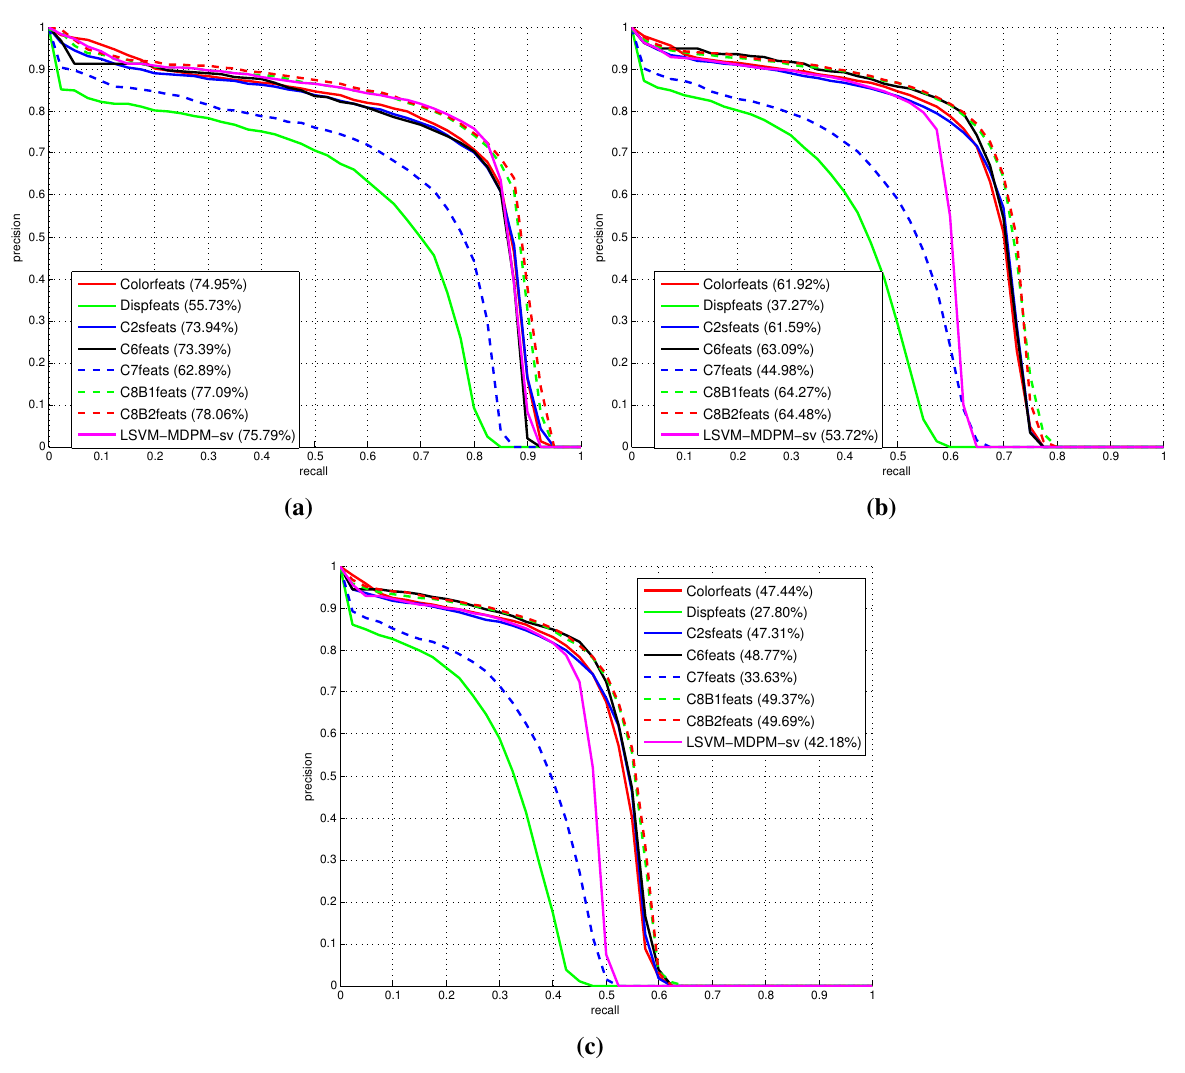
Figure 10. Comparison of the 3D-aware features average precision (AP) performance for the class ‘car’. ( a ) Easy; ( b ) moderate; ( c )